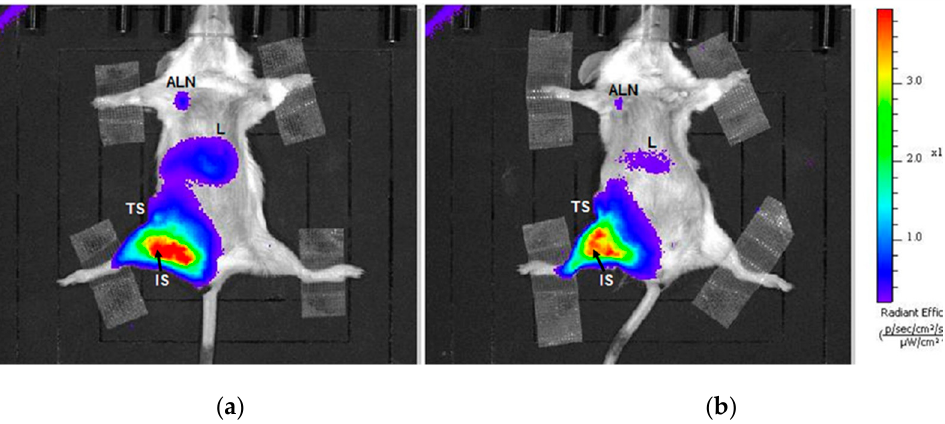
Figure 2. Representative images of in vivo fluorescence from ( a ) MN and ( b ) MNOX group. Fluo-